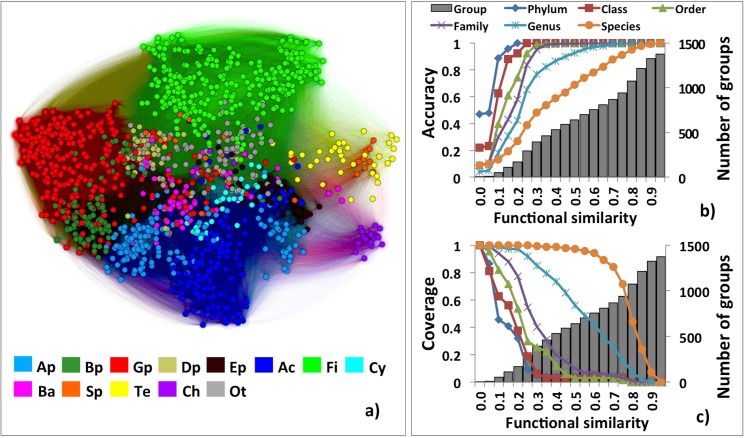

Fusion-based clustering correlates with NCBI Taxonomy.(a) fusion network colored by taxonomic rank. Ap-Alphaproteobacteria; Bp-Betaproteobacteria; Gp-Gammaproteobacteria; Dp-Deltaproteobacteria; Ep-Epsilonproteobacteria; Ac-Actinobacteria; Fi-Firmicutes; Cy-Cyanobacteria; Ba-Bacteroidetes; Sp-Spirochaetes; Te-Tenericutes; Ch-Chlamydiae; Ot-other minor phyla; (b) The overall accuracy of functional similarity networks at cut-offs from 5% to 100%, with step of 5%. The overall network accuracy is the fraction of correctly assigned organisms of the total number of organisms; i.e. overall accuracy of 100% indicates that all organisms in any one cluster are of the same taxon. The overall accuracy for each taxonomy level increases with the cut-off. Thus, lower taxonomy levels (e.g. genus, species) achieve 100% overall accuracy at higher cut-offs; (c) The overall coverage of the functional similarity networks at cut-offs from 5% to 100%, with step of 5%. The overall coverage is the percentage of taxa (excluding taxonomic singletons) with all members in one cluster at a given cut-off. Overall coverage of 100%, indicates no splitting of any of the taxa; i.e. one cluster per taxon. Lower taxonomy levels lose 100% overall coverage at higher cut-offs.